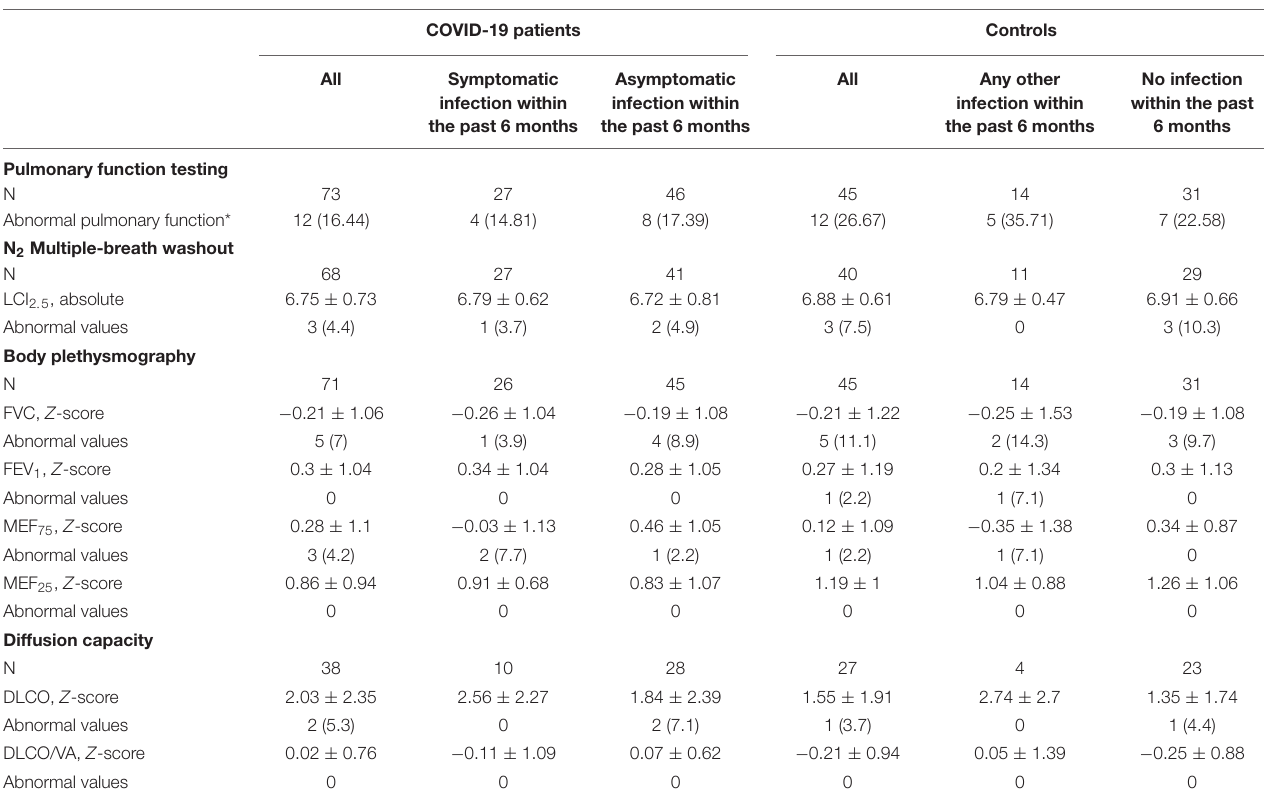
TABLE 5 | Pulmonary function